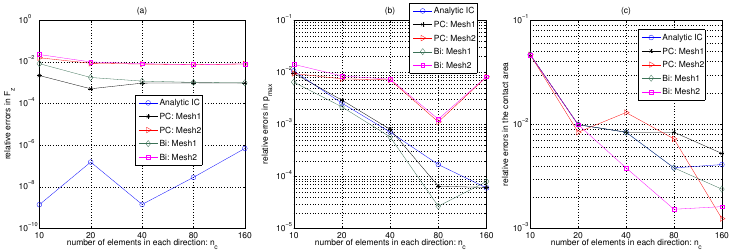
Figure 12. Normal contact problem with different ICs: (a) errors in the normal force, (b) errors in the maximal pressure, (c) errors in the contact area. Here, “PC” and “Bi” denote piecewise constant and bilinear loads, respectively. The horizontal axis shows the number of elements in each direction of contact grid n c × n c